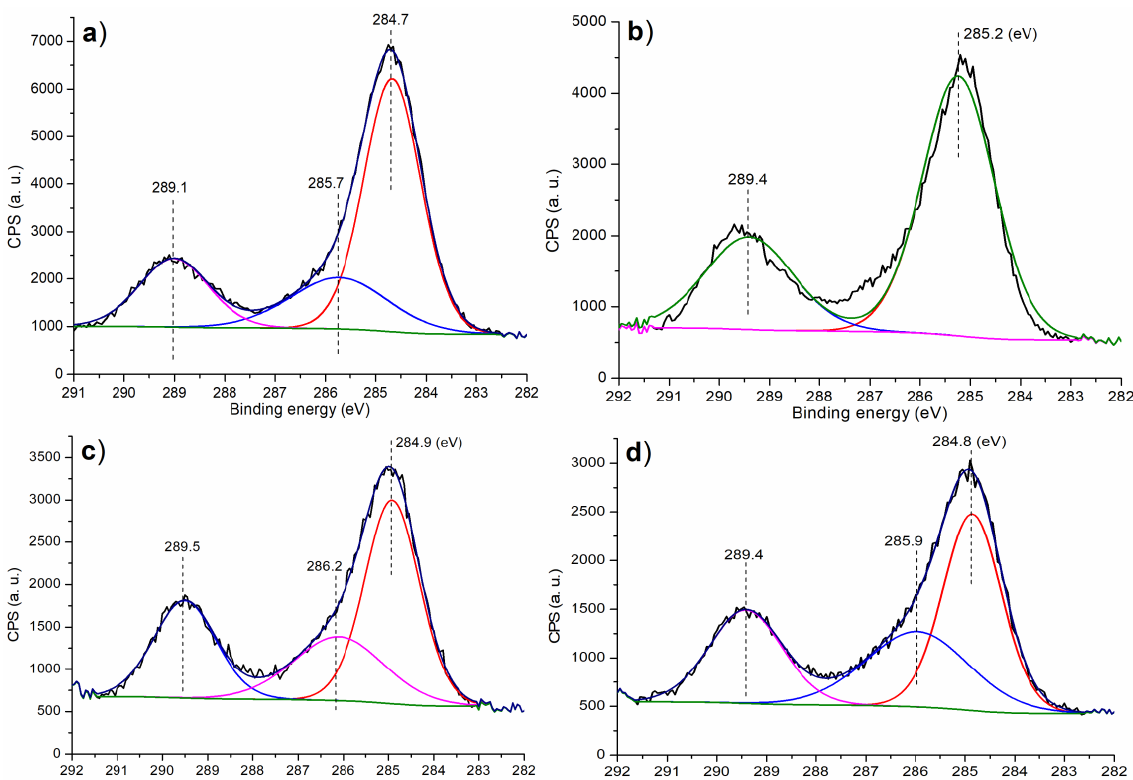
Figure 5. XPS measurements of the C 1s region: ( a ) Cement, ( b ) sample 2, ( c ) sample 7, and ( d ) sample 10.